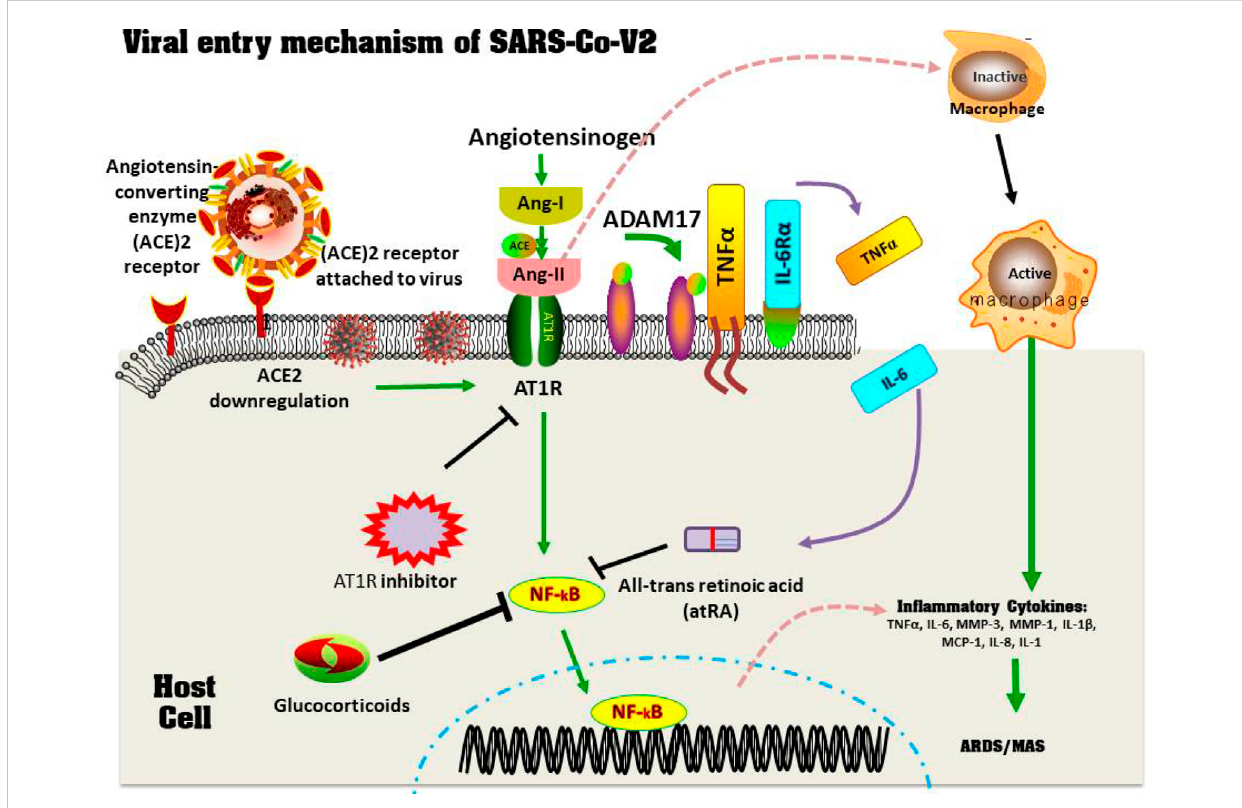
FIGURE 6 The emergence of MAS and ACE-2 Downregulation in a COVID-19 patients. Through the spike protein, the viruses accesses the host cell by connecting with the ACE-2 active site. Later, the virus suppresses ACE-2 impression, which causes Ang II to increase. Ang II is a RAS pathway product formedbythebreakdownofAngIbytheenzymeACE.ThroughNF- κ Bsignaling,increasedAng-IIbindswithit'sownreceptorAT1R,modulatingthegene expression of several in fl ammatory cytokine productions. This Ang-II/AT1R connection also affects macrophage responses, which results in the production of in fl ammatory cytokines productions, leading to ARDS or MAS. Furthermore, some metallo-proteases, such as ADAM17, convert these proin fl ammatory cytokines and ACE-2 receptors factors to a dissolved form, that aid inside the removal of surfaces ACE-2 ’ s protective mechanism and that may contribute to SARS development. Therapy using glucocorticoids, AT1R blockers, as well as all-trans retinoic acid suppresses NF- κ B regulation, which reduces cytokines storms and improves SARS-CoV2 disease severity (Based on Banu et al., 2020. Copyright. Elsevier 2020).